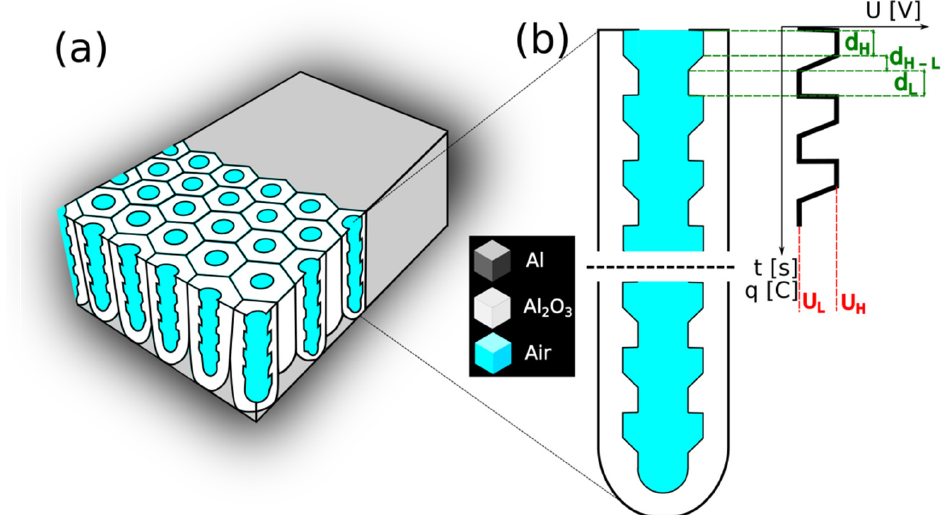
Figure 1. A scheme of ( a ) the PAA-based DBR; and ( b ) the pore architecture with d H and d L segment thickness resulting from the anodization under U H and U L pulses, respectively (d H–L is the transition layer formed during the gradual voltage decrease from U H to U L ).